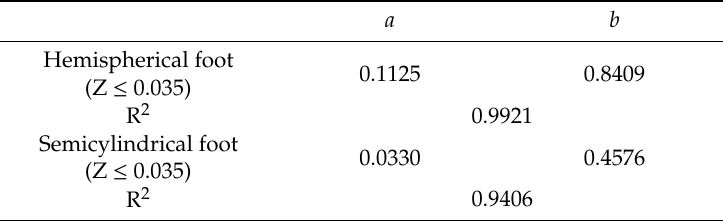
Table 5. The relationship between the cross-sectional area and the intrusion depth.